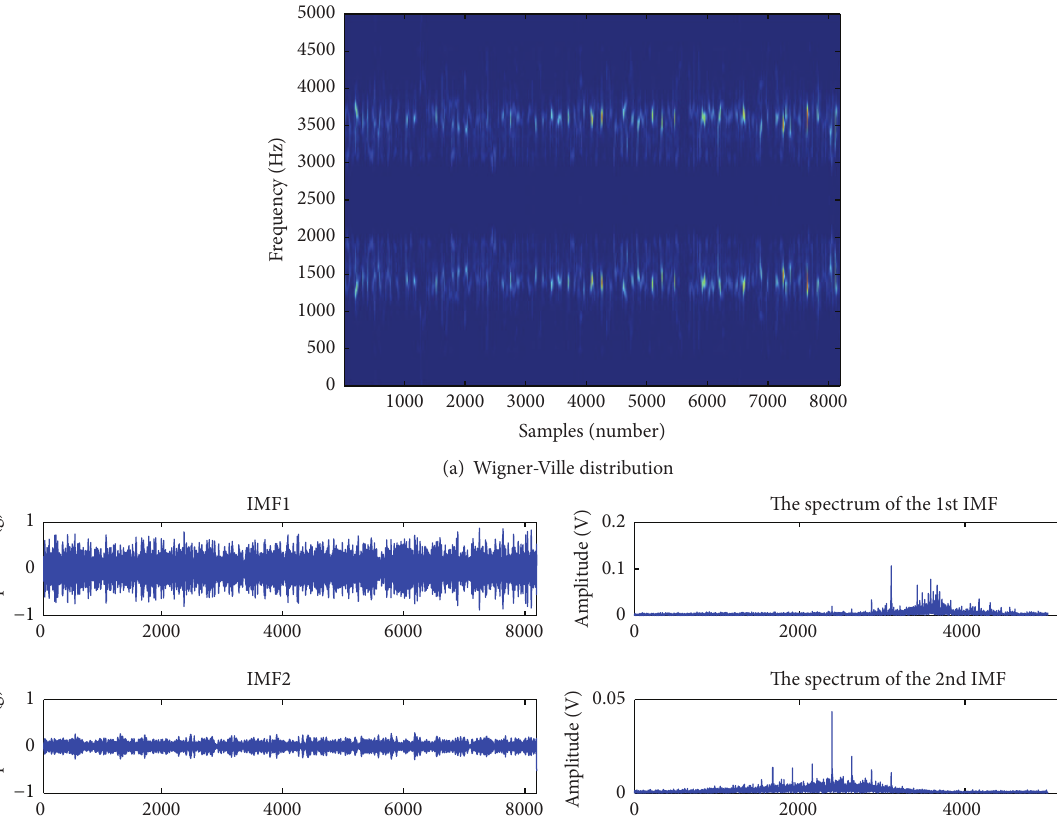
(b) The first four IMFs and their spectrums